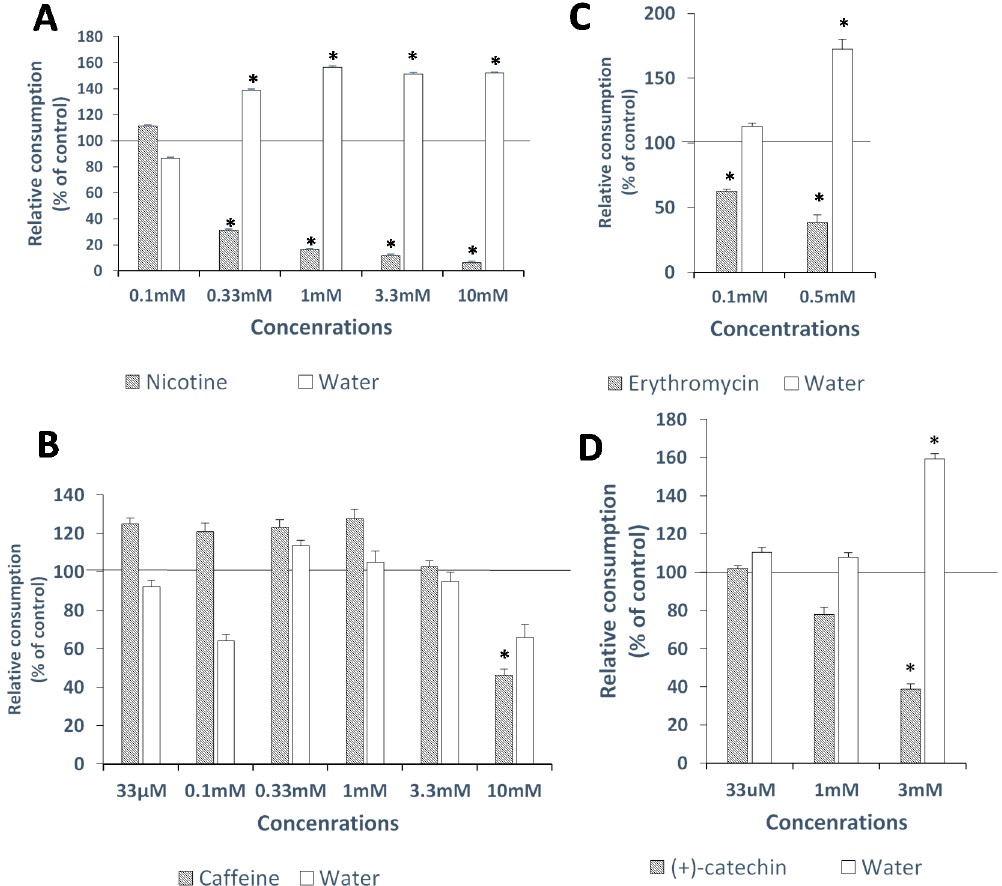
Figure 2. Effects of different concentrations of bitter tastants on consumption parameters. Tastant side consumption (filled bars: ( A ) Nicotine; ( B ) Caffeine; ( C ) Erythromycin; ( D ) (+)-Catechin) and water side consumption per chick (open bars) as percentage of control, during 24 h. Consumption parameters were normalized to the distilled water control group (=100%, indicated by black line at 100). Bars represent consumption (represented as percentage of control group) ±SEM. * Significantly different ( p ≤ 0.05) from control group using Dunnett’s Method.